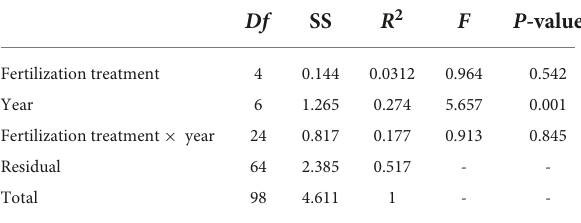
TABLE 3 PERMANOVA analysis results to depicted the differences in the bacterial and archaeal community compositions of soils from La Mare (Reunion Island) according to the organic material treatment, time, and organic material treatment × time (1,000 permutations, significance threshold: P <